Question: Draft a figure caption describing what is shown.
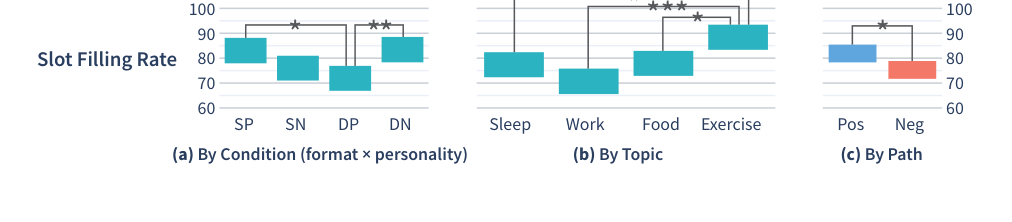
Answer: 95% confidence intervals of slot filling rate by variables with a significant effect: (a) the combination of the information format and personality modifier represented as study condition; (b) topic; and (c) the conversation path. The asterisks with arms indicate significance between the connected categories. (Refer to Appendix A.3 for model details and statistics.)